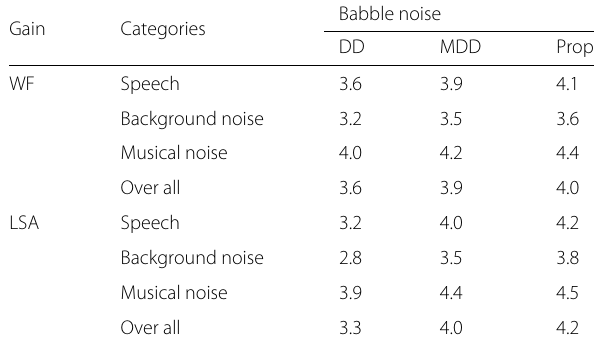
Table 11 Listening test results for pink noise at 10 dB input SNR Gain Categories